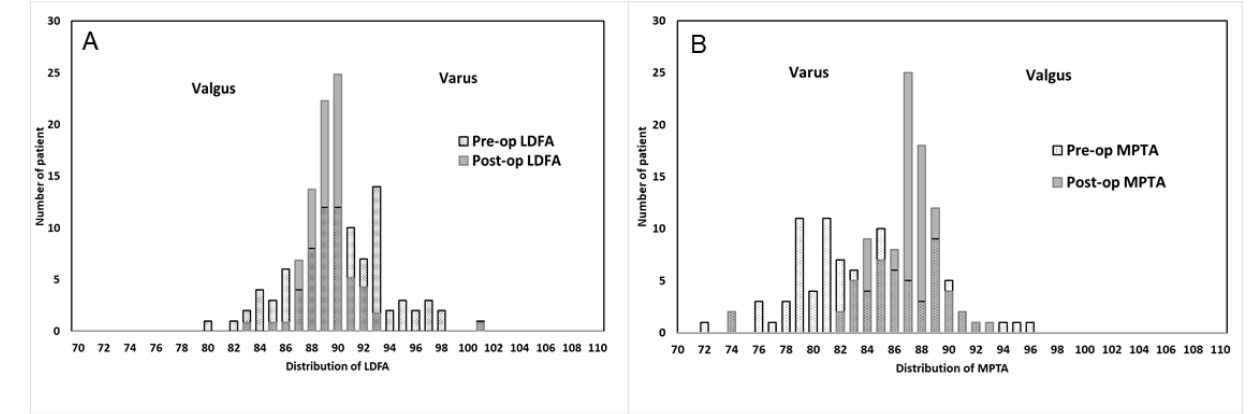
Figure 2. The pre-op and post-op ( A ) LDFA and ( B ) MPTA distribution. LDFA = lateral distal fem- oral angle, MPTA = medial proximal tibial angle. angle, MPTA = medial proximal tibial